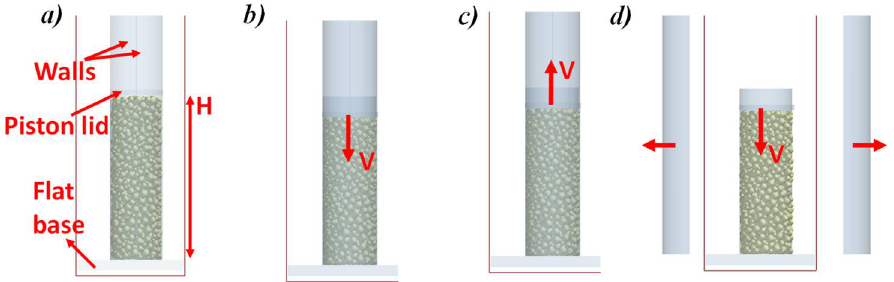
Figure 5. Steps of the simulation: ( a ) generation of the powder bed; ( b ) compaction of the bed with the lid; ( c ) relaxation of the bed; ( d ) unconfined compression with the lid. H is the initial height of the powder bed; V is the scrolling velocity of the circular piston lid. The red arrows indicate the direction of movement of the geometrical elements.